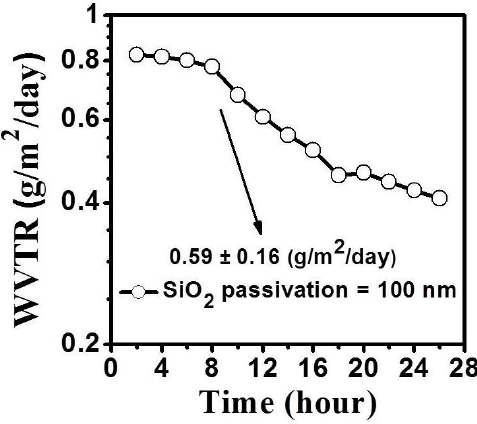
Figure 6. Water vapor transmission rate of polycarbonate substrates with a 100-nm-thick SiO 2